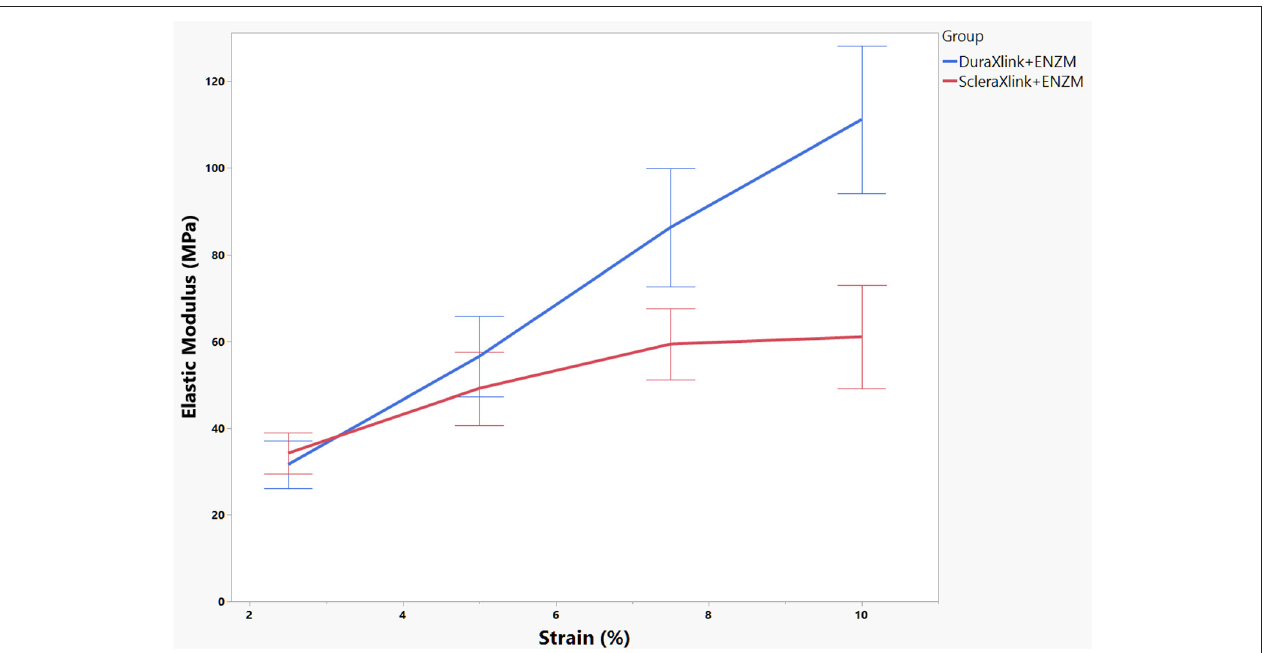
FIGURE 5 | Elastic modulus of each sample was calculated at four strain locations. The mean and standard error of the modulus were presented. DuraXlink, crosslinked dura, ScleraXlink, crosslinked sclera; PBS, phosphate buffered saline; ENZM, protease XIV, 1 U/ml with 1%